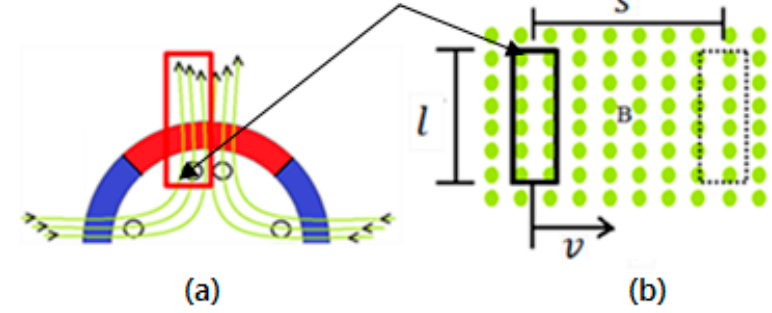
Figure 6. Representation of the relative displacement between coil conductors and the stator magnetic field. ( a ) Frontal view; ( b ) top view.